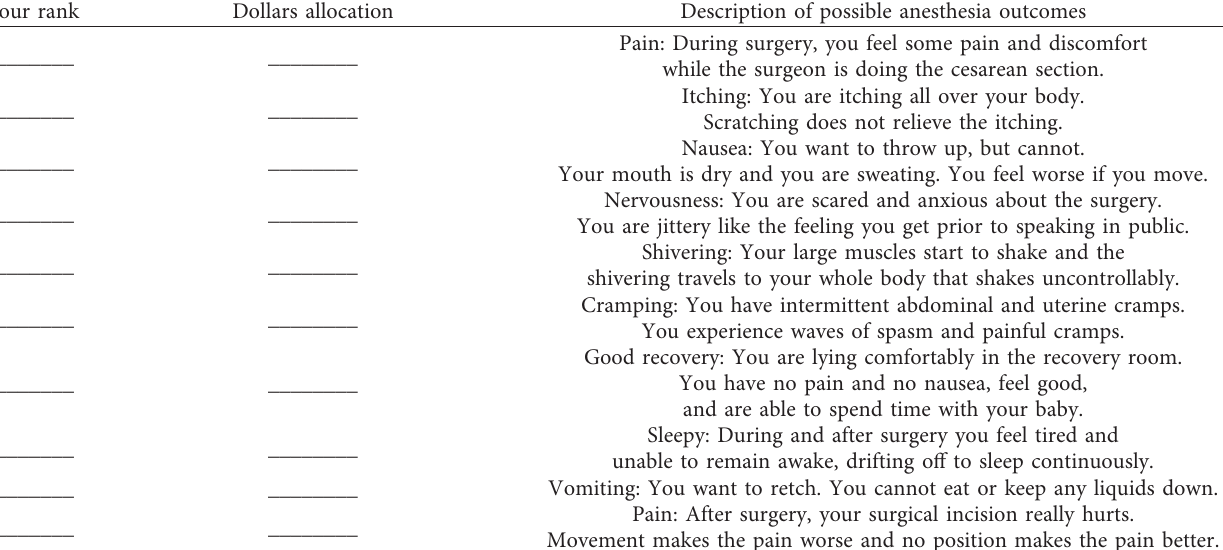
Table 6: Dollars allocation.